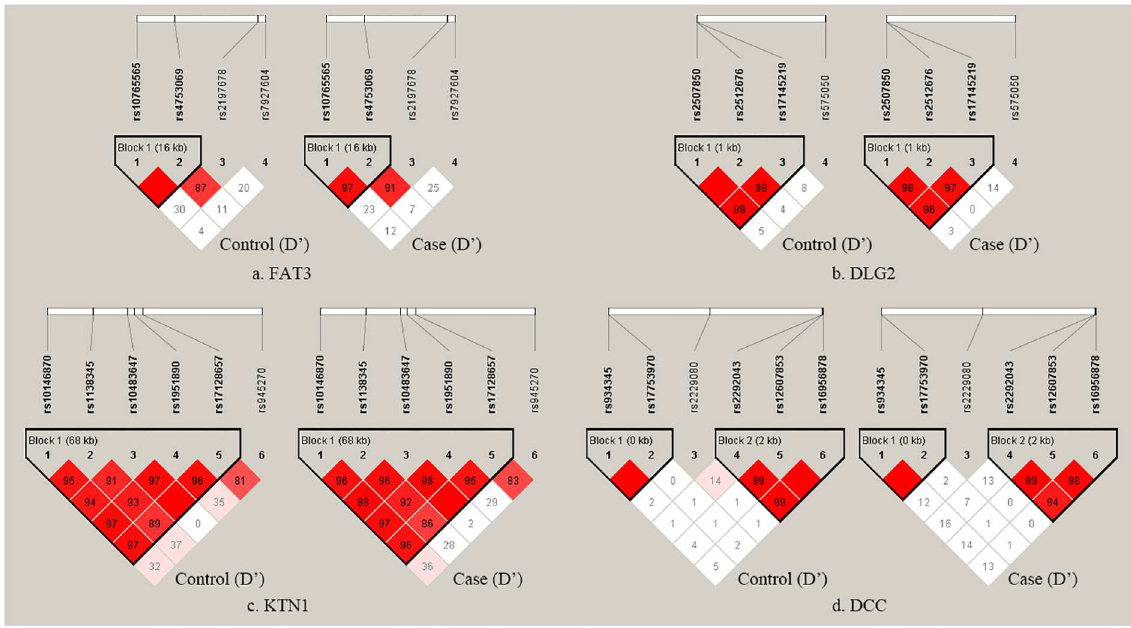
Fig 1. LD plot of the 20 SNPs in four genes in the control (left) and case (right) groups. (a) LD plot of the 4 SNPs of the FAT3 gene in the control (left) and case (right) groups. (b) LD plot of the 4 SNPs of DLG2 gene in the control (left) and case (right) groups. (c) LD plot of the 6 SNPs of the KTN1 gene in the control (left) and case (right) groups. (d) LD plot of the 6 SNPs of the DCC gene in control (left) and case (right) groups. The values in squares are the D’ calculated using pair-wise analyses. Empty squares indicate D’ = 1 (i.e. complete LD between a pair of